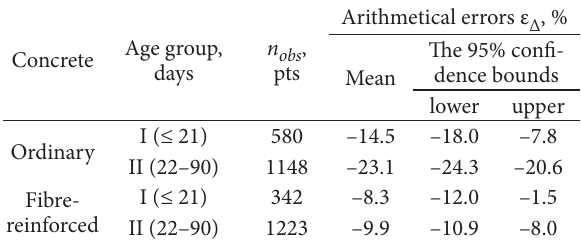
Table 4. The arithmetical errors of the EN 1992-1-1:2004